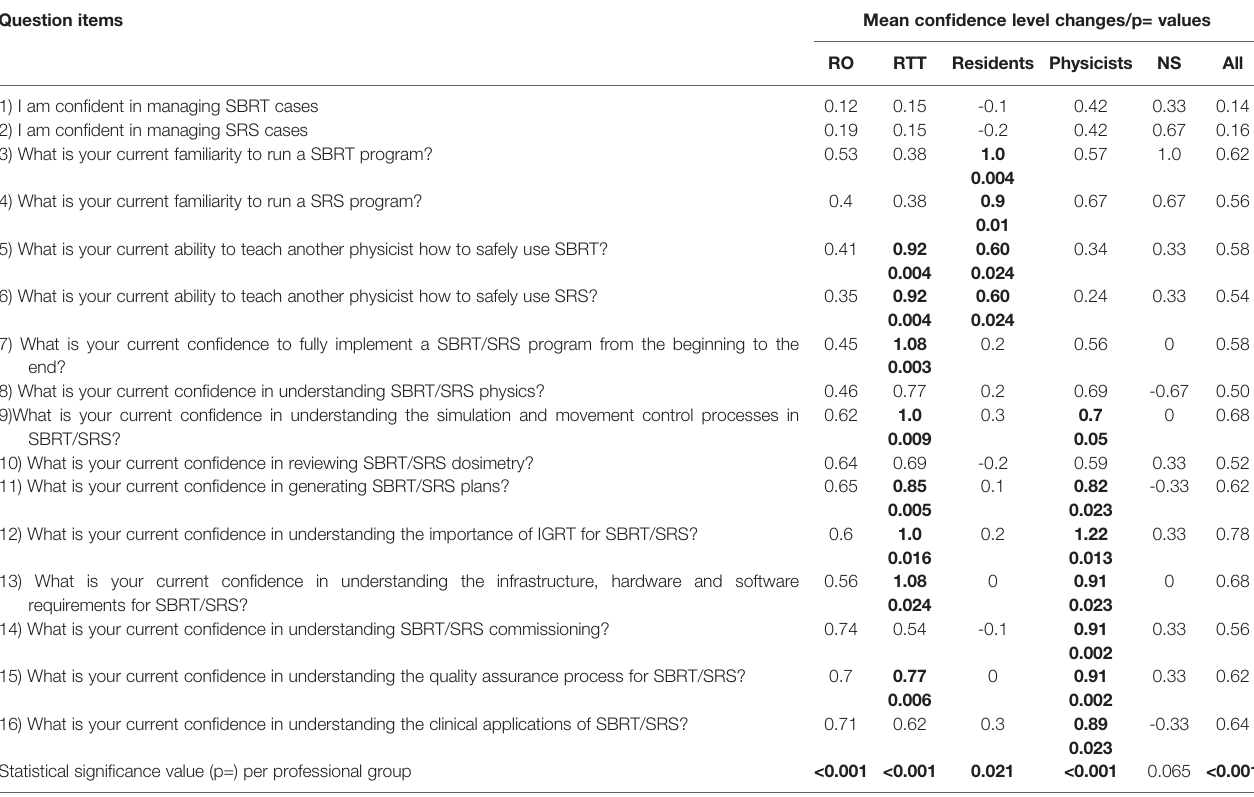
TABLE 3 | Con fi dence level dynamics after remote training. Question